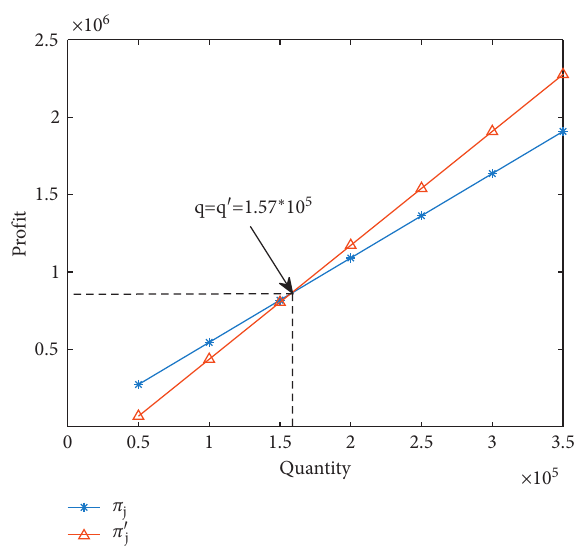
Figure 5: Profits of retailers with different scales when n �